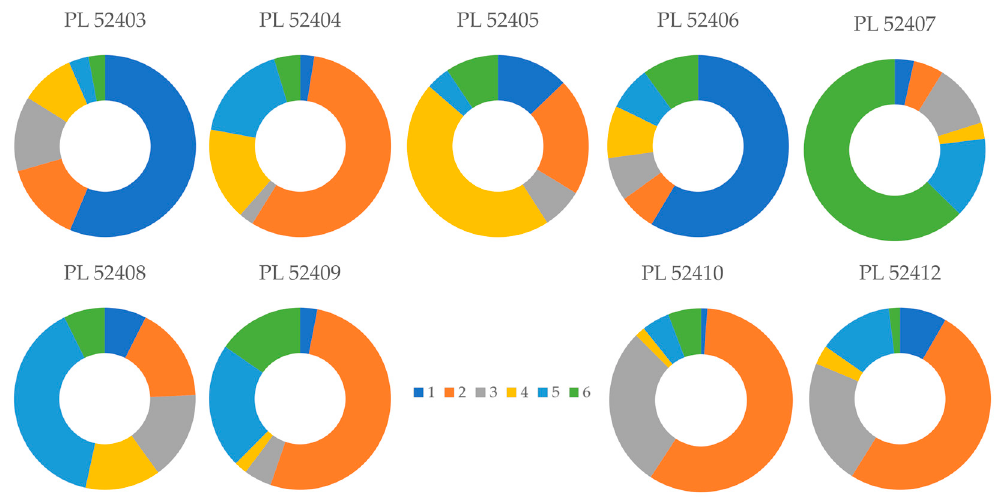
Figure 7. Proportion of six groups in nine accessions of Avena macrostachya Bal. ex Cross. et Durieu. Groups resulted from 50,000 burn-ins and 250,000 Markov Chain Monte Carlo generations of STRUCTURE software [33] with K = 6. The analysis based on sequence-related amplified polymorphism (SRAP) markers.